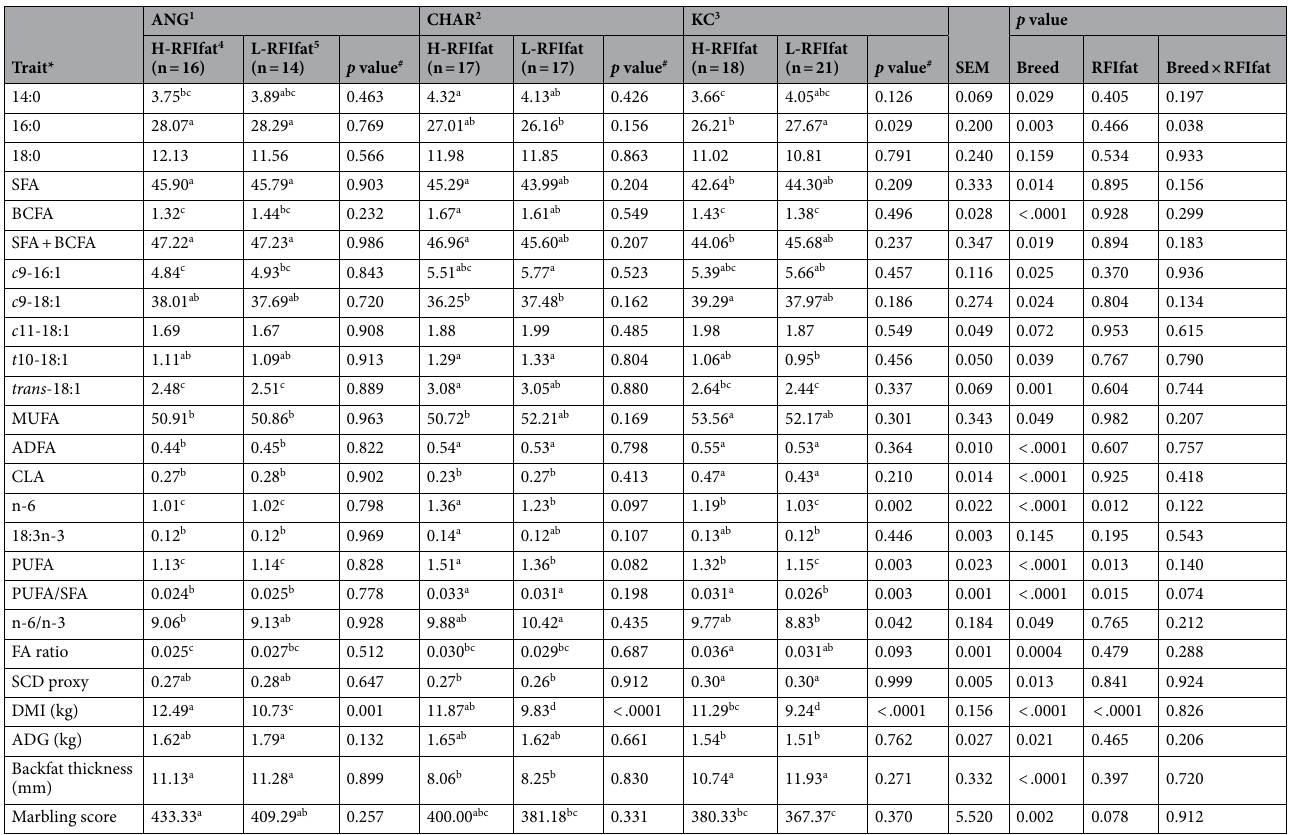
Table 3. Effects of breed and residual feed intake adjusted for backfat thickness (RFIfat) on fatty acid proportion (%) in subcutaneous tissues and performance traits of beef cattle. * c = cis ; t = trans ; SFA (sum of saturated fatty acid) = 10:0 + 12:0 + 14:0 + 15:0 + 16:0 + 17:0 + 18:0 + 19:0 + 20:0; BCFA (sum of branched chain fatty acid) = iso -14:0 + iso -15:0 + anteiso -15:0 + iso -16:0 + iso -17:0 + anteiso -17:0 + iso -18:0;